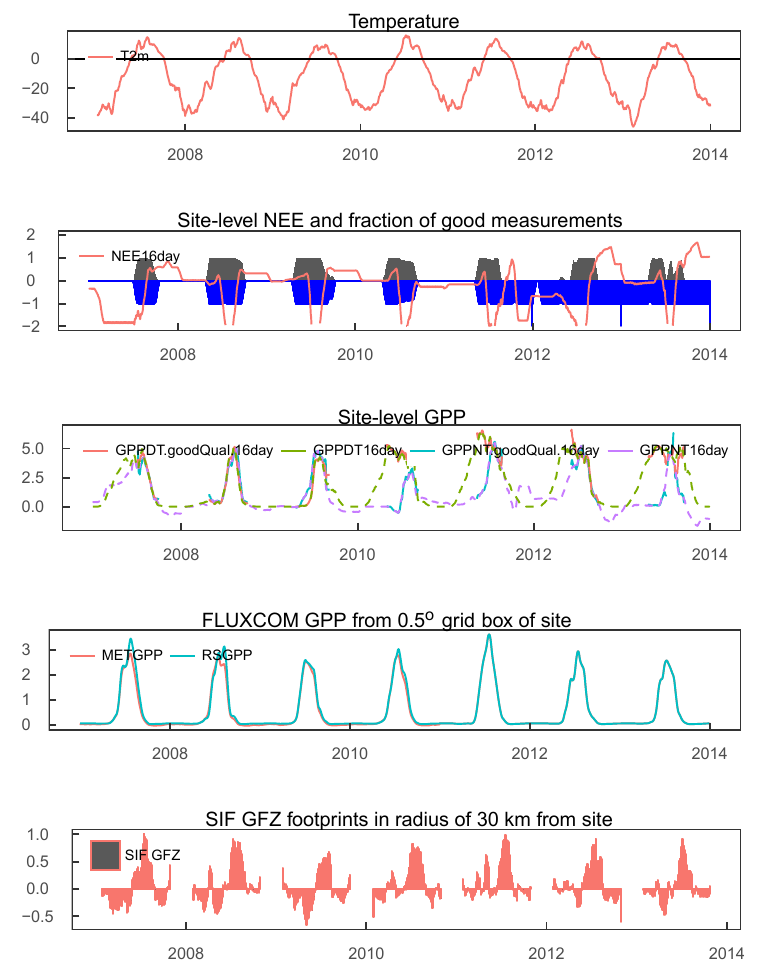
Figure A14. RU-Cok: Time series (16 day averages) of quality filtered air temperature and NEE; blue bars indicate fraction of available good quality temperature data and gray bars indicate fraction of good and gap-filled NEE data. The middle panel depicts the GPP derived from the night-time and daytime partitioning of NEE measurements, filtered for 80% of good quality and gap-filled NEE along with unfiltered measurements. The modelled GPP is taken from the 0.5 ◦ grid cell with centre coordinates closest to the tower. The bottom panel displays the 16 day averages of SIF GFZ footprints within 30km of the